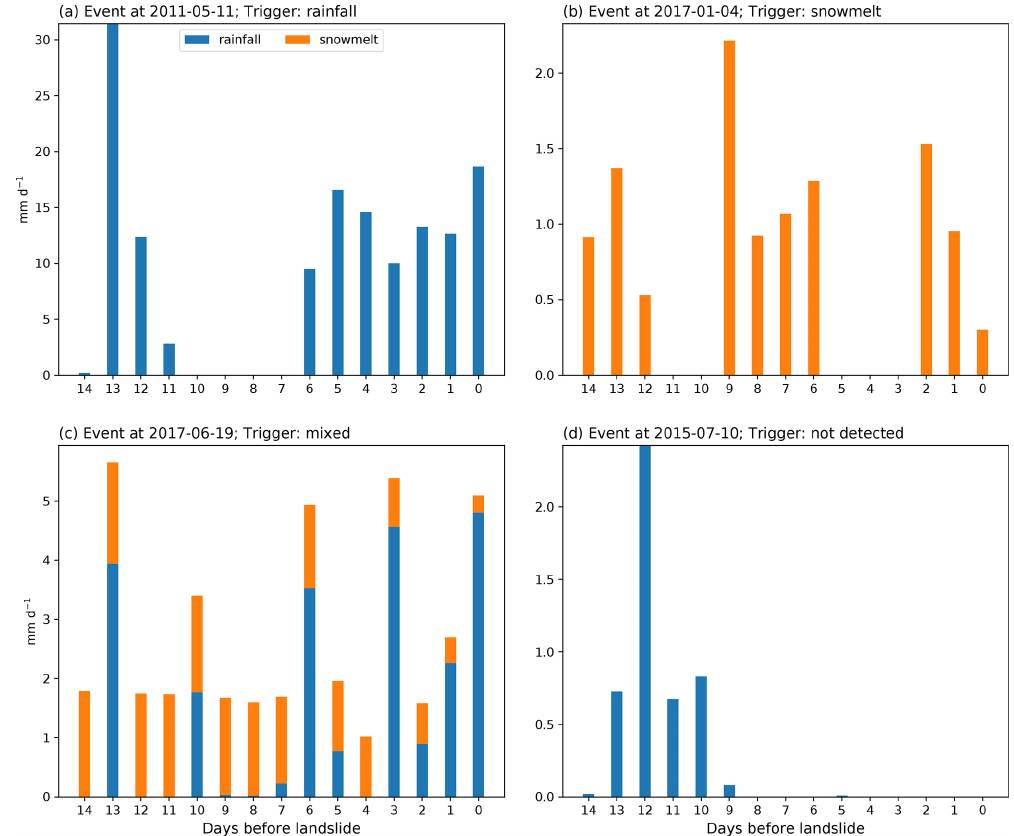
Figure A1. Event-based temporal process of rainfall and snowmelt for selected landslide events with landslide triggers defined as (a) rainfall, (b) snowmelt, (c) mixed, and (d) not detected, according to the method described in Sect.